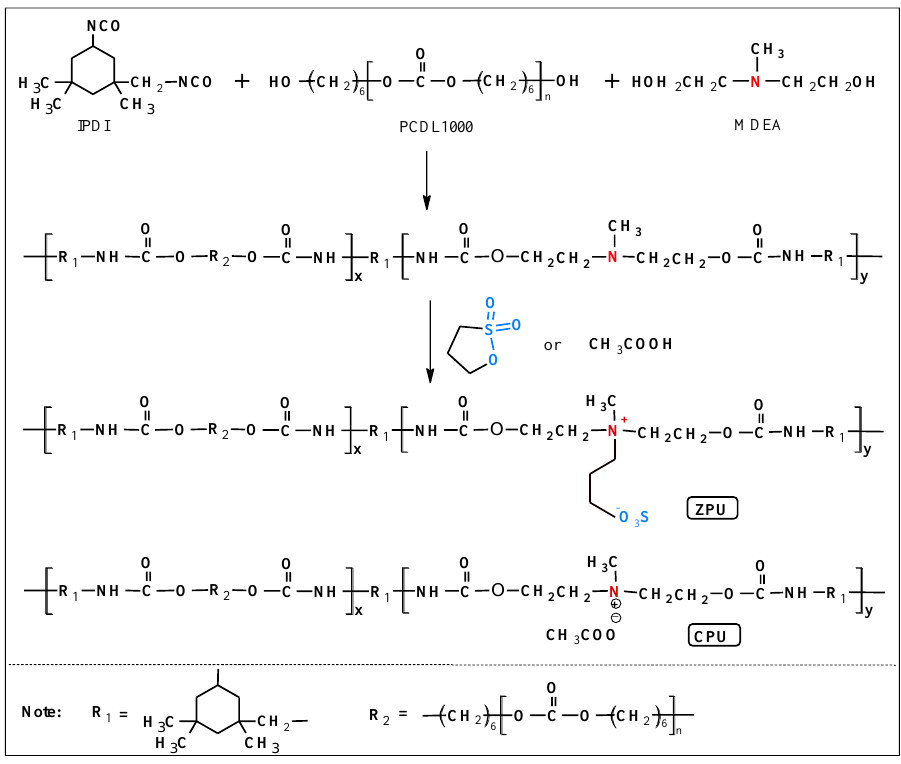
Figure 1. Synthetic routes of ZPU and